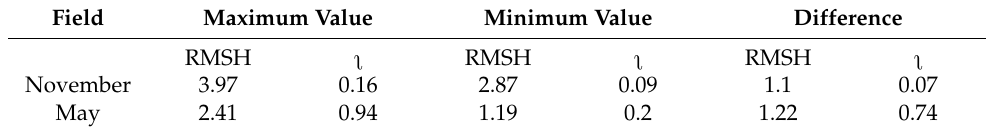
Table 2. The range of surface roughness variations in terms of mean RMSH and mean ğ for all fields.